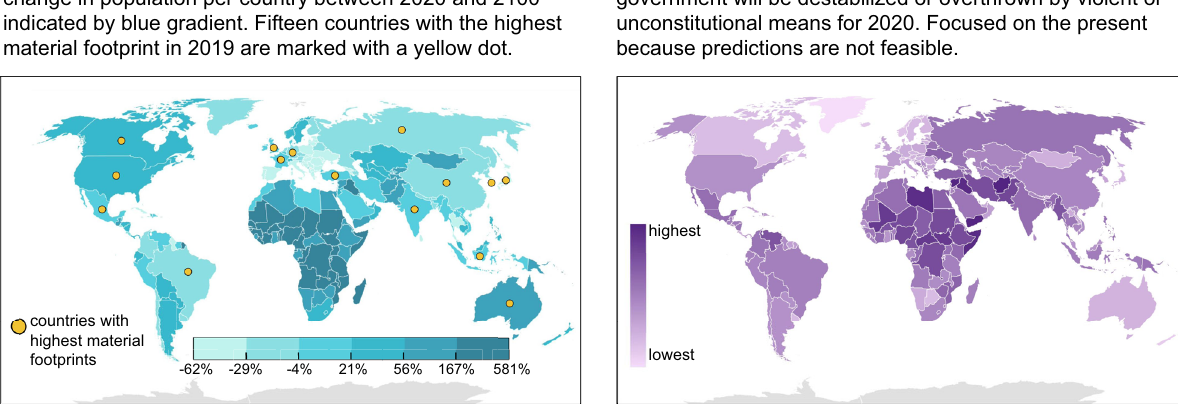
Fig. 1 Global patterns of restoration commitments, projected effects of climate change, overexploitation of resources, and political instability. The areas where many restoration activities are being implemented or planned ( a ) are also disproportionately affected by climate change ( b ), overexploitation of resources ( c ), and political instability ( d ). Data sources: a Restoration commitments from the Global Restoration Commitments Database by the PBL Netherlands Environmental Assessment Agency 90 . b Climate change represented by the number of days above 35 °C in the period 2080 – 2099 from the Climate Impact Lab. 85,91 . c Human population growth from the United Nations World Population Prospects 2019 49 and national material footprint from the United Nations Environment Programme International Resource Panel Global Material Flows Database 92 (a list of the 15 countries is provided in Supplementary Table 1); d Political instability from the Worldwide Governance Indicators project by the World Bank 93